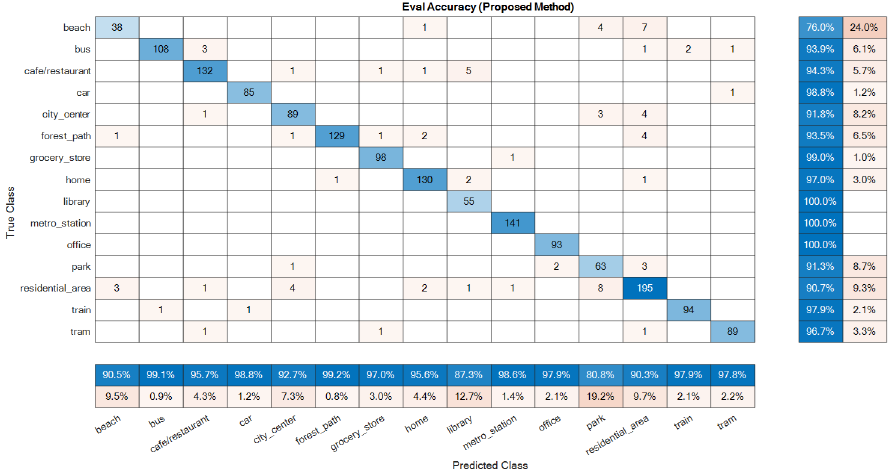
Figure 9. Confusion matrix built for the proposed method as to the evaluation data: